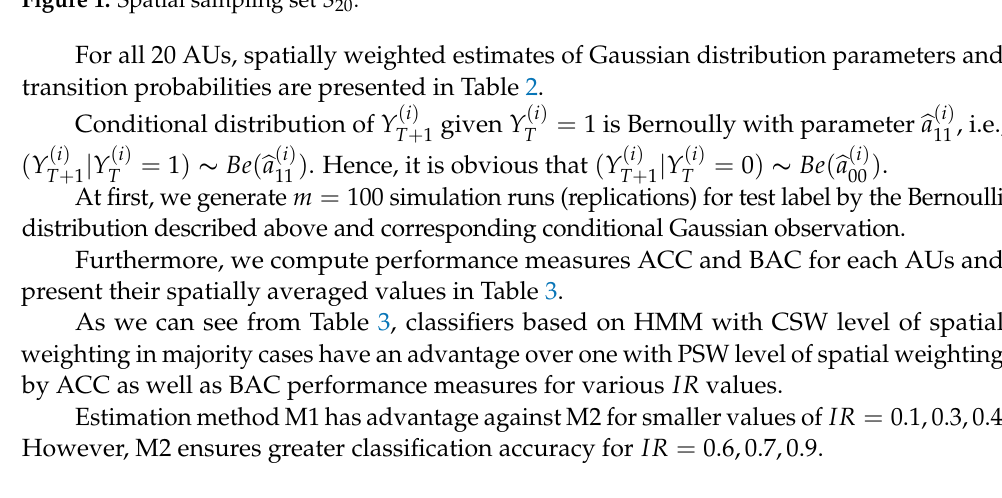
Figure 1. Spatial sampling set S 20